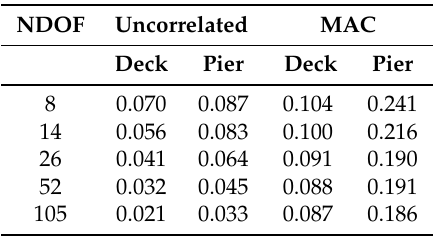
Uncertainty Propagation to Modal Frequencies and MAC